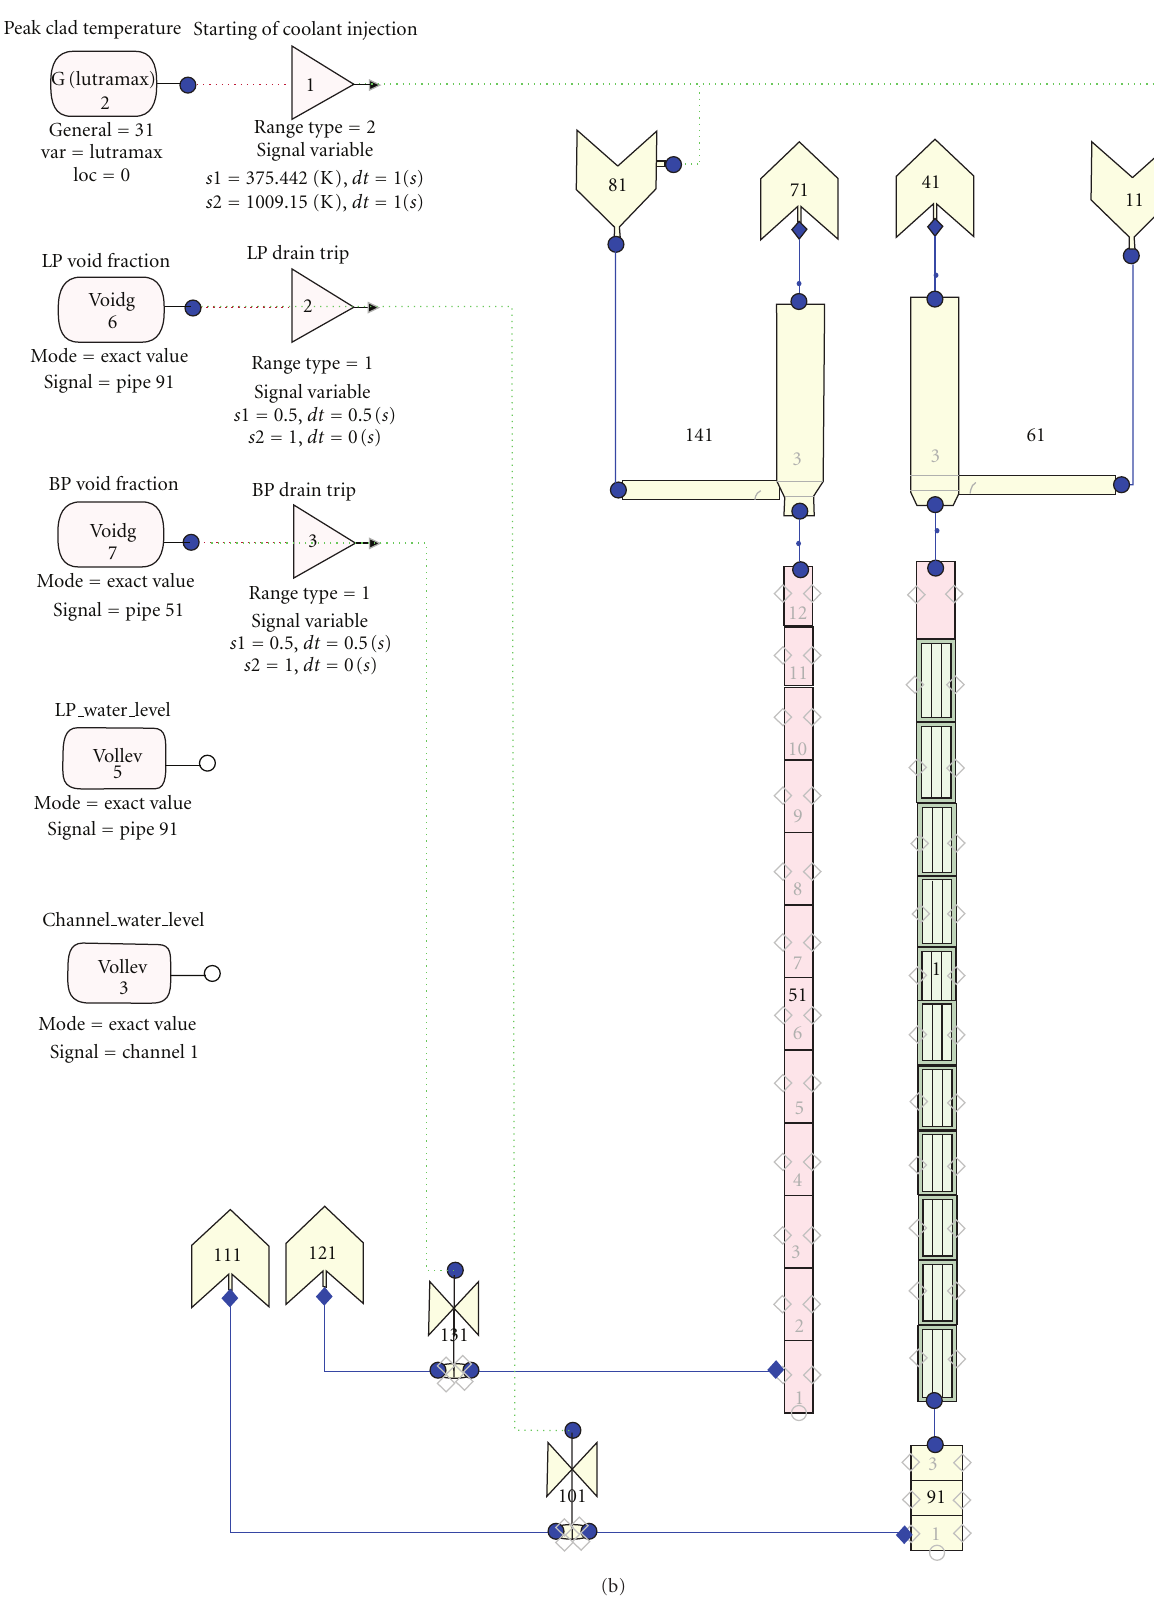
Figure 5: Nodalization diagrams for PIPE (a) and CHAN (b)